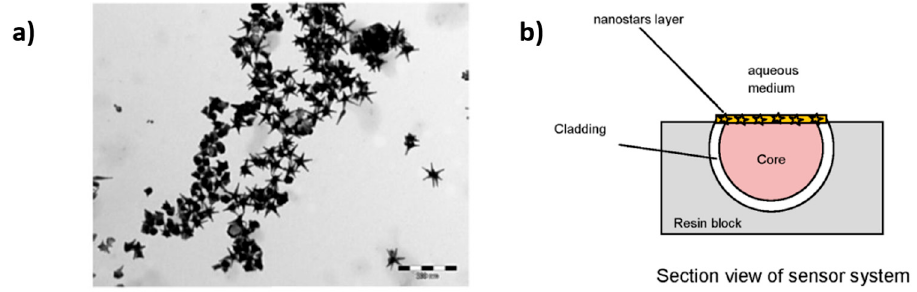
Figure 13. ( a ) TEM image of the five-branched gold nanostars (GNS); ( b ) Optical sensor system based on LSPR in POF. Reprinted with permission from Ref. [81].